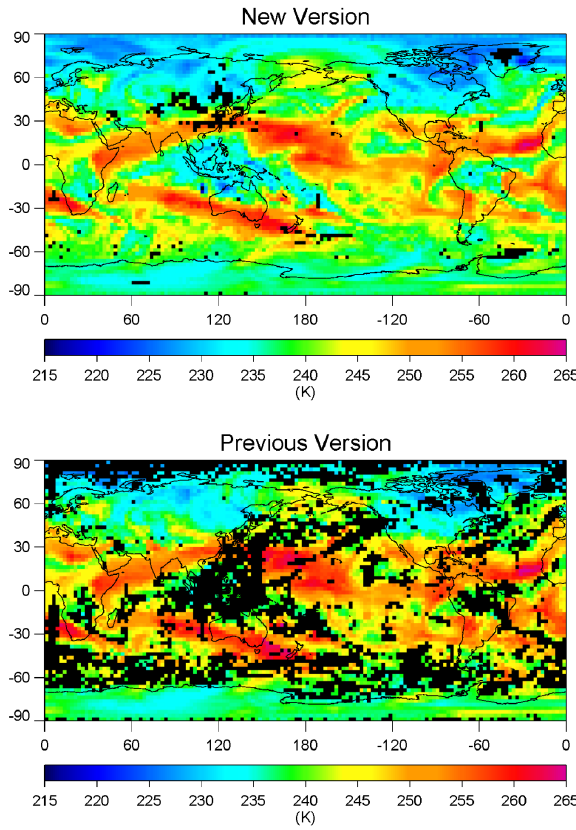
Fig. 2. Comparison of one-day’s spatial coverage between the new version and the previous column-clear-sky version of Shi and Bates (2011). The example is taken from METOP-A observations on 15 January 2011.